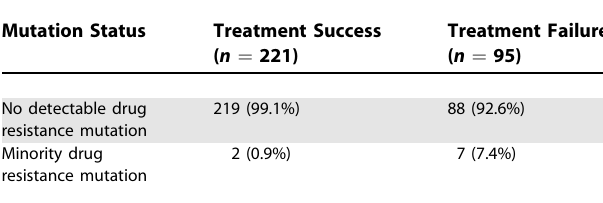
Figure S1. Evidence of Minority Drug Resistance Mutation Linkage and Dissociation by Mutation-Specific Amplicon Sequencing A transmitted mutant group virus sample that had only K103N by bulk genotyping also had an unlinked minority M184V þ T215N variant that was detected by the 215 PCR test. ‘‘ ... ’’ , nucleotides from the contiguous sequence not shown. Found at doi:10.1371/journal.pmed.0050158.sg001 (77 KB PDF).